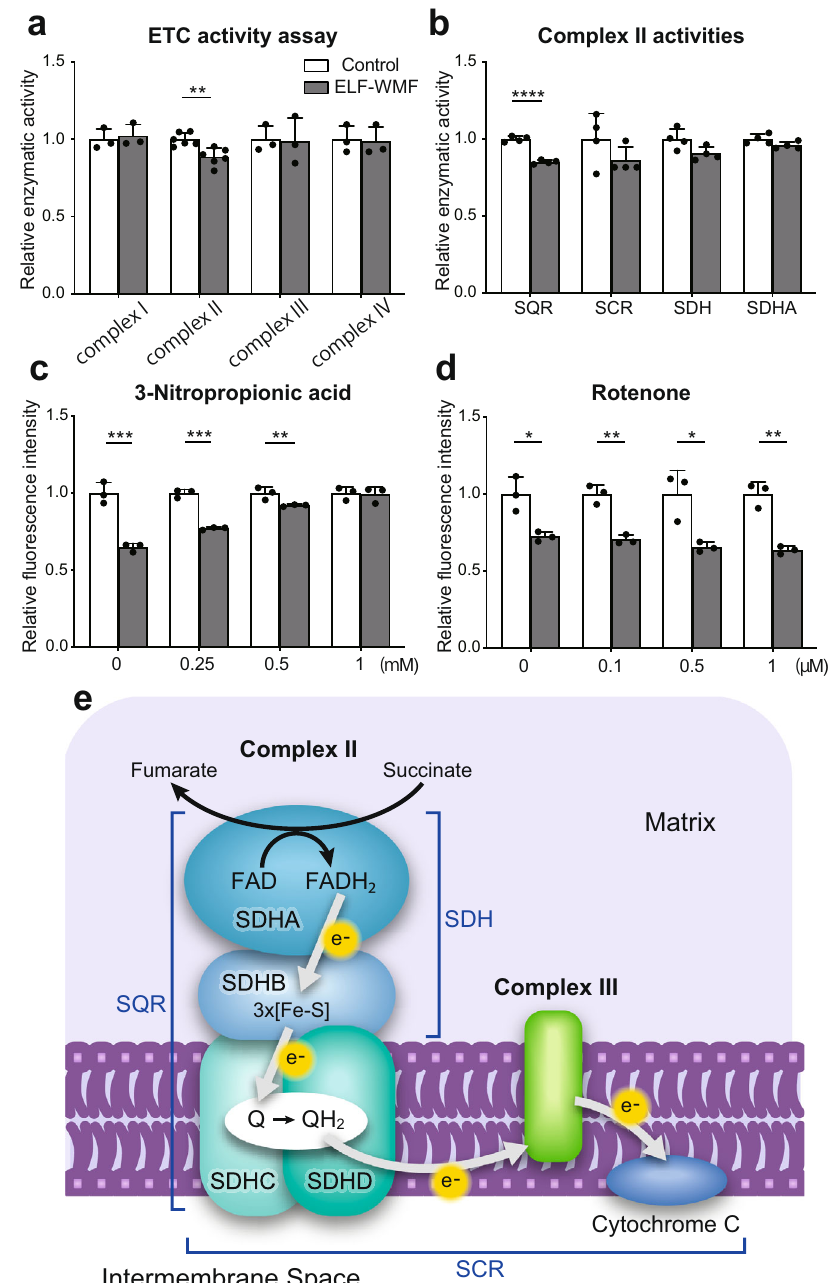
Fig. 6 Opti-ELF-WMF suppressed the activities of the mitochondrial electron transport chain (ETC) complex II. a Relative enzymatic activities of mitochondrial ETC complex I, II, III, and IV of mouse liver homogenates exposed to Opti-ELF-WMF in vitro for 8 min (mean ± SD, n = 3 to 6 mice each; ** q < 0.01 by multiple Student ’ s t -tests). b Fractional and extended ETC complex II activities (succinate:quinone reductase [SQR], succinate-cytochrome c reductase [SCR], succinate dehydrogenase [SDH], succinate dehydrogenase fl avoprotein subunit [SDHA]) of isolated mitochondria exposed to Opti-ELF- WMF in vitro for 8 min (mean ± SD, n = 4 mice each; **** q < 0.0001 by multiple Student ’ s t -tests). See e for a schematic of the fractional enzymatic activities. c Mitochondrial mass (MitoTracker Green) of AML12 cells treated with variable concentrations of a mitochondrial ETC complex II inhibitor, 3-nitropropionic acid, exposed to Opti-ELF-WMF in cellulo (mean ± SD, n = 3 culture dishes each; ** q < 0.01 and *** q < 0.001 by multiple Student ’ s t -tests). d Mitochondrial mass (MitoTracker Green) of AML12 cells treated with variable concentrations of a mitochondrial ETC complex I inhibitor, rotenone, exposed to Opti-ELF-WMF in cellulo (mean± SD, n = 3 culture dishes each; * q < 0.05, and ** q < 0.01 by multiple Student ’ s t -tests). e Schematic to indicate the fractional and extended enzymatic activities of mitochondrial ETC complex II measured in b . Complex II is composed of SDHA, SDHB, SDHC, and SDHD. See also Fig.